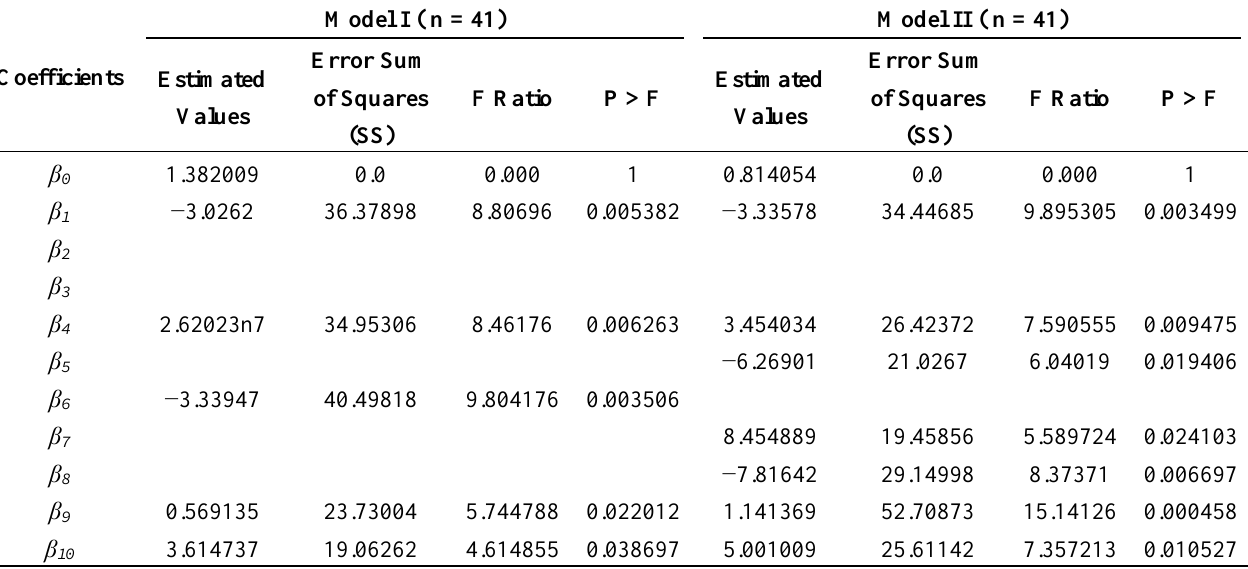
Table 3. Regression coefficients, estimated values and precision indexes of the